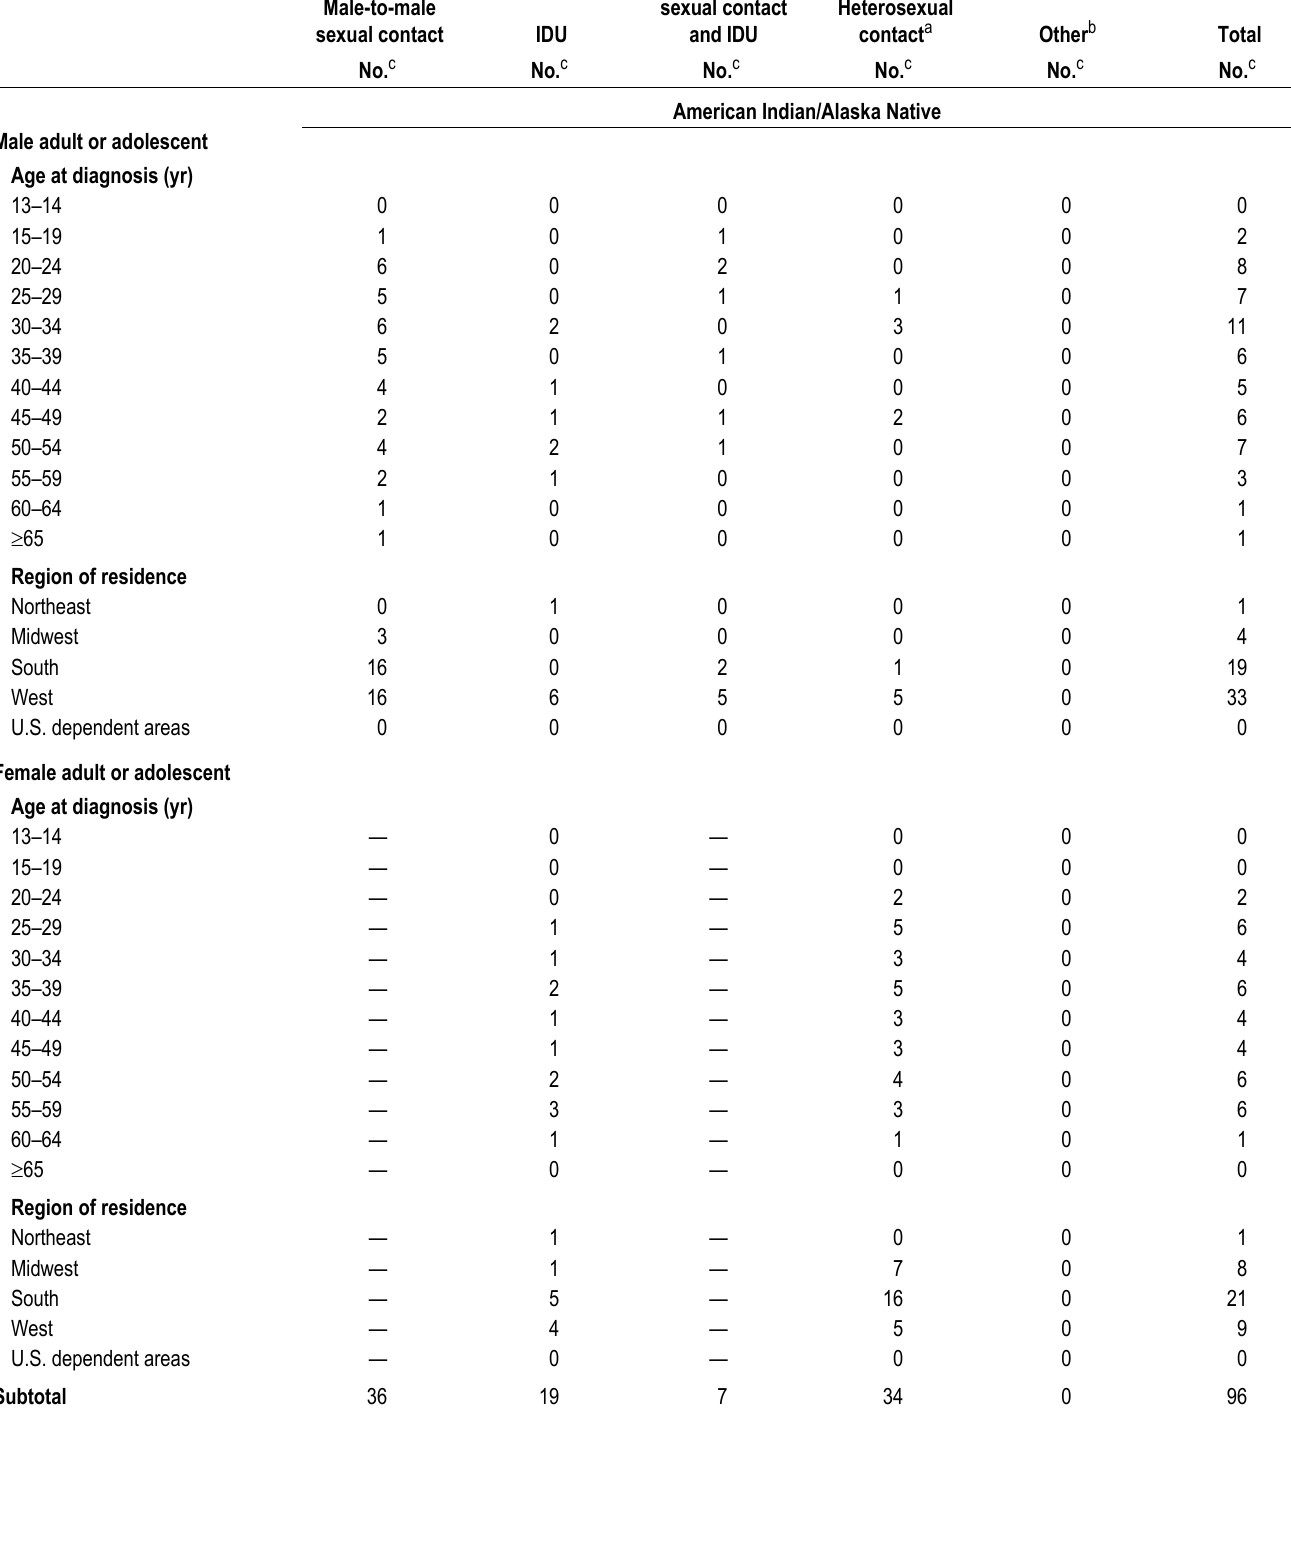
Table 6b. Stage 3 (AIDS), by transmission category, race/ethnicity, and selected characteristics, 2015—United States and 6 dependent